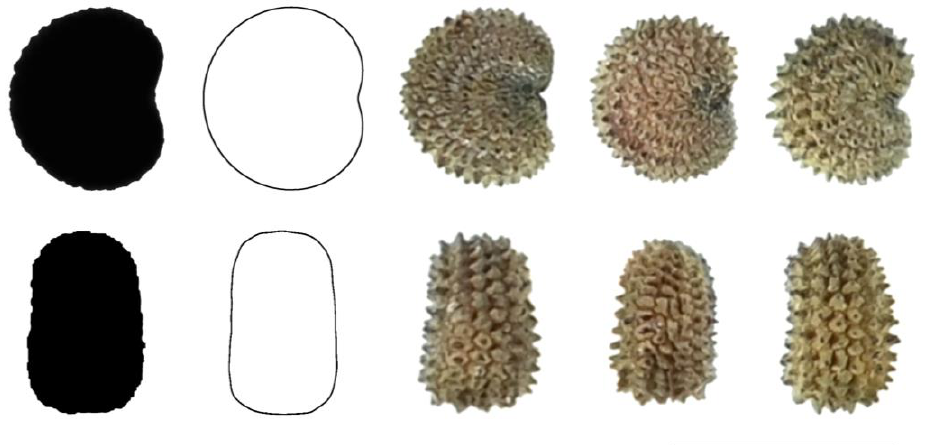
Figure 6. Silene fruticosa : average silhouettes (left), the models giving best scores with 20 seeds (LM2 and DM3), and three representative images for the lateral (above) and dorsal (below) seed views. Bar represents 1 mm.